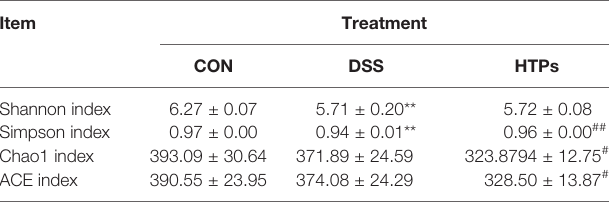
TABLE 4 | Alpha diversity parameters assessed by Ace, Chao1, Shannon, and Simpson indices.